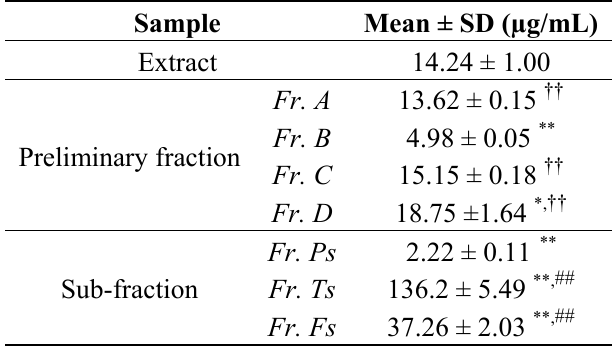
values of different fractions from EGb on A β 42 Table 8. IC 50